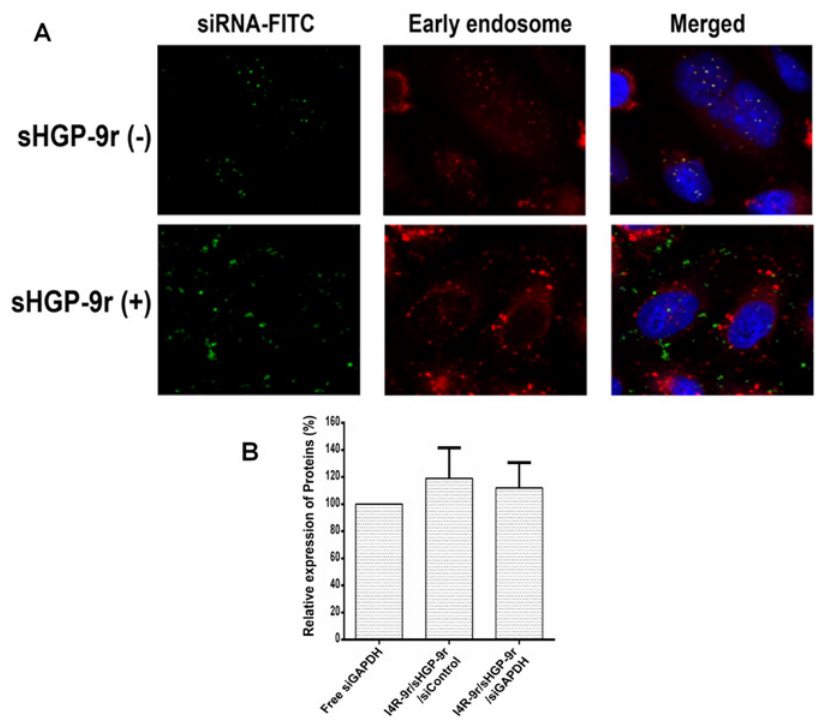
Fig 2. Addition of sHGP-9r to facilitate endosome escape of nanocomplexes. (A, Top) Confocal microscopy images of HeLa cells pretreated with the early endosome marker-RFP, and subsequently incubated with I4R-9r PwSN carrying FITC labeled siRNA. Images were pseudocolored for visualization: blue = DAPI; red = early endosome marker-RFP; green = FITC-siRNA. (A, Bottom) Confocal microscopy images of HeLa cells after treatment with FITC-siRNA encapsulated in I4R-9r PwSNs, which compose of sHGP-9r at molar ratio of 1:19 (sHGP-9r: I4R-9r). (B) The gene silencing efficacies against GAPDH protein with or without the sHGP-9r peptides was assessed by Western blot. Results are presented as mean of relative immunoblot intensities ± standard deviation (n = 6).